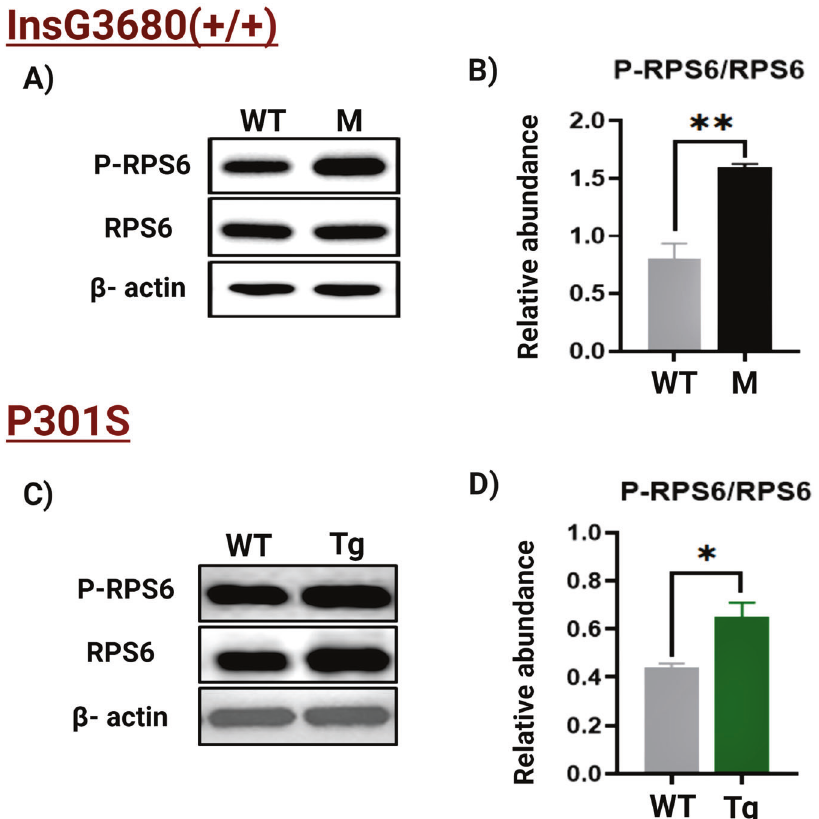
Fig. 4 WB analysis. A Representative WB of RPS6 and P-RPS6 prepared from the cortex tissues from the WT mice ( n = 5) and ASD mouse model (abbreviated with M; n = 5). B The relative average WB intensity of P-RPS6, showing a signi fi cant increase in the phosphorylation levels of the RPS6 in mutant mice compared to the WT. The data are normalized to RPS6 and beta-actin presented as mean ± SEM. A two-tailed t -test was conducted. ** P < 0.01. C Representative WB of RPS6 and P-RPS6 prepared from the cortex tissues from the WT mice ( n = 5) and AD mouse model (abbreviated with Tg; n = 5). D The relative average WB intensity of P-RPS6, showing a signi fi cant increase in the phosphorylation levels of the RPS6 in Tg mice compared to their WT littermates. The data are normalized to RPS6 and beta-actin presented as mean ± SD. A two- tailed t -test was conducted. * P <